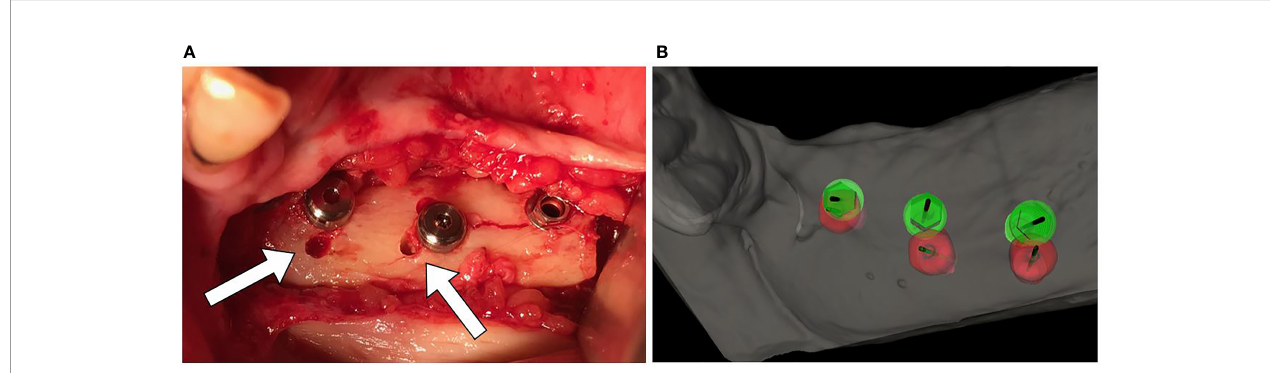
FIGURE 9 | (A) Mismatch between the initial 2-mm drilled holes suggested by the static splint (see white arrows) and the fi nal intraoperative implant position achieved with dynamic navigation guidance. (B) Static splint-based dynamic navigation accuracy is higher than static navigation alone in this double-barrel fi bula case. Postoperative implant position analysis, the achieved position in red, the virtual surgical planned position in